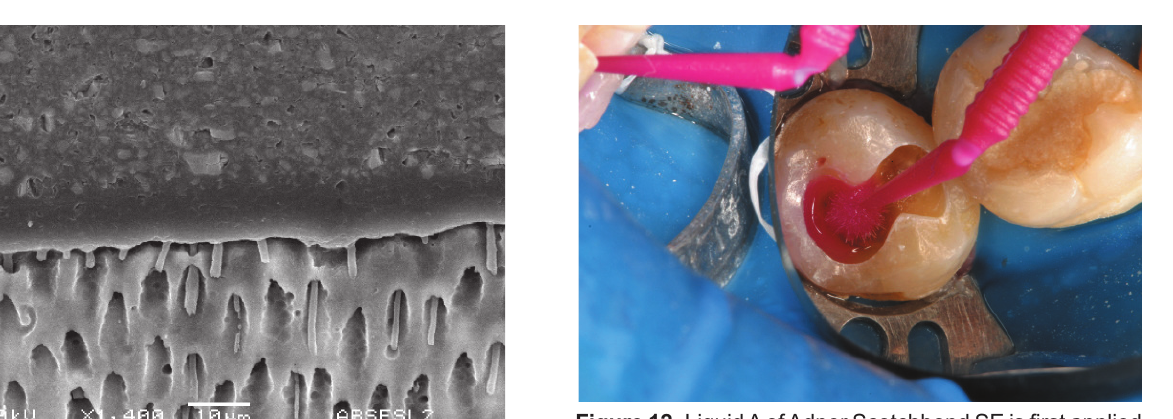
Figure 12- "1(?3(+"@"%>"@+#,'"A)%-)$ %.+"AB"(&"9'&-"*##2(,+" to the cavity. Water is the main compound of this part of the system